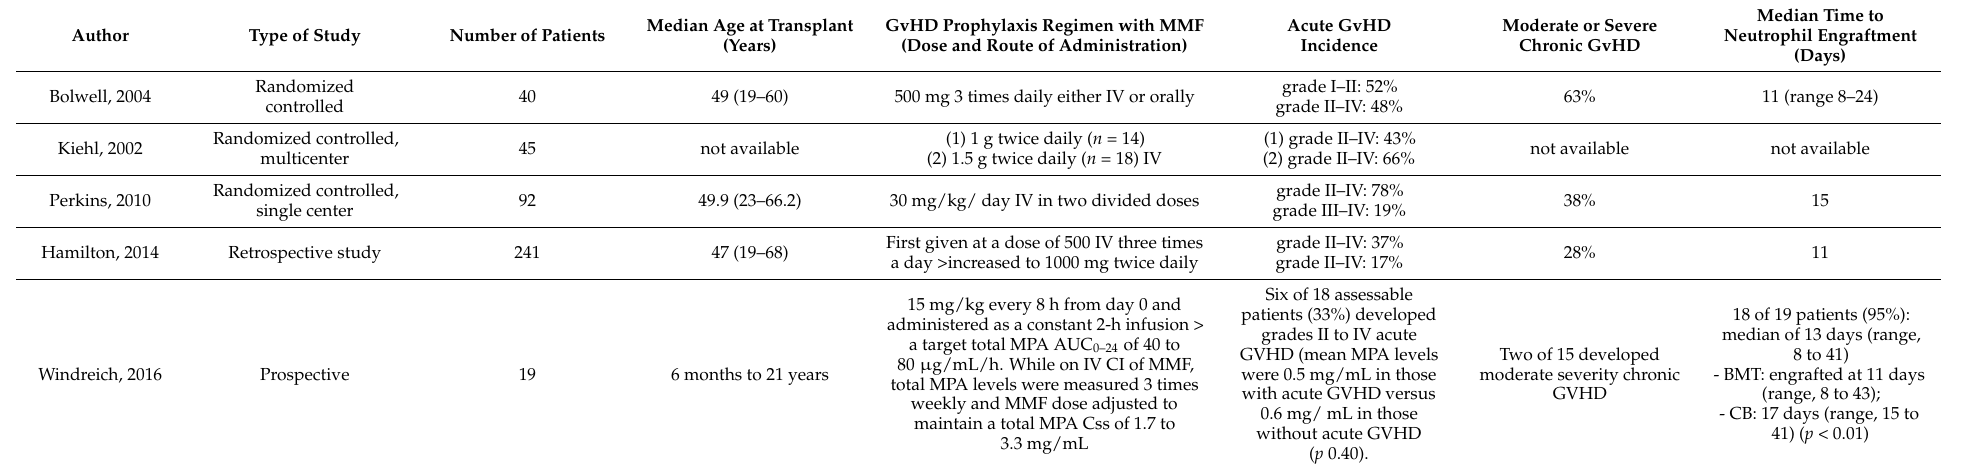
Table 3. Main characteristics, demographics, and efficacy data of selected